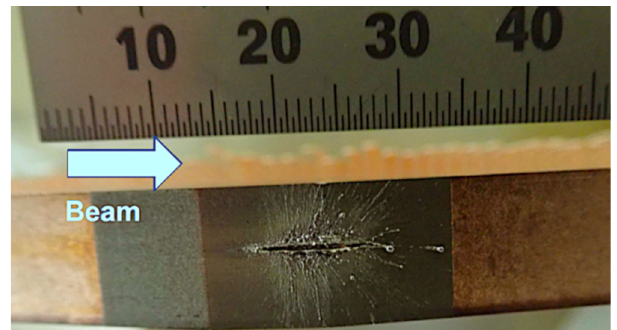
FIG. 25. Schematic of beam collimator structures and those installed in the tunnel for (a) LER and (b) HER.